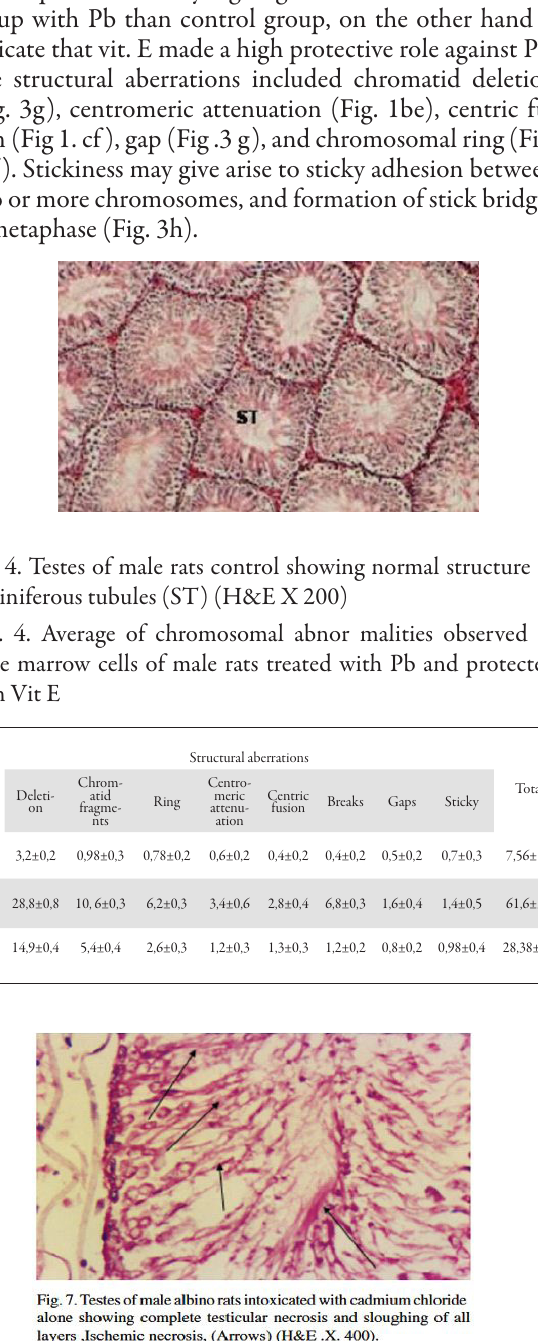
Fig. 5. Testes of male rat intoxicated with lead acetate showing complete testicular necrosis and sloughing of all layers, ischemic necrosis (arrows) (H&E X